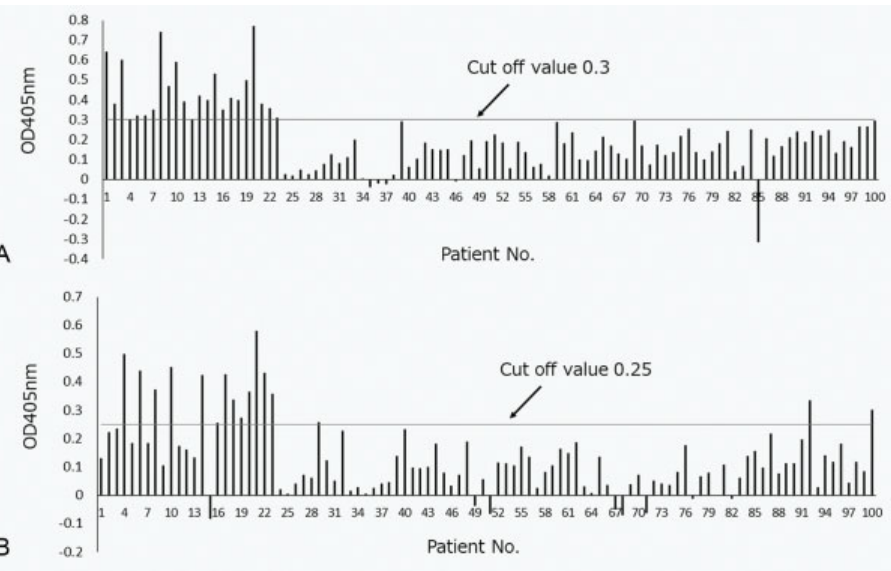
Fig. 2. ( A ) Binding of autoantibodies to the synthetic peptide ASQ41 by ELISA. ( B ) Binding of autoantibodies to the synthetic peptide EGH22 by ELISA. ELISA was performed using amino plates coated with 10 µM of the peptides or scramble peptides. IgM anti-ASQ41-positive patient plasma or normal control plasma (1:100) was applied, followed by an alkaline-phosphatase-conjugated secondary antibody. The absorption at 405 nm was then measured. ELISA, enzyme-linked immunosorbent assay; IgM, immunoglobulin